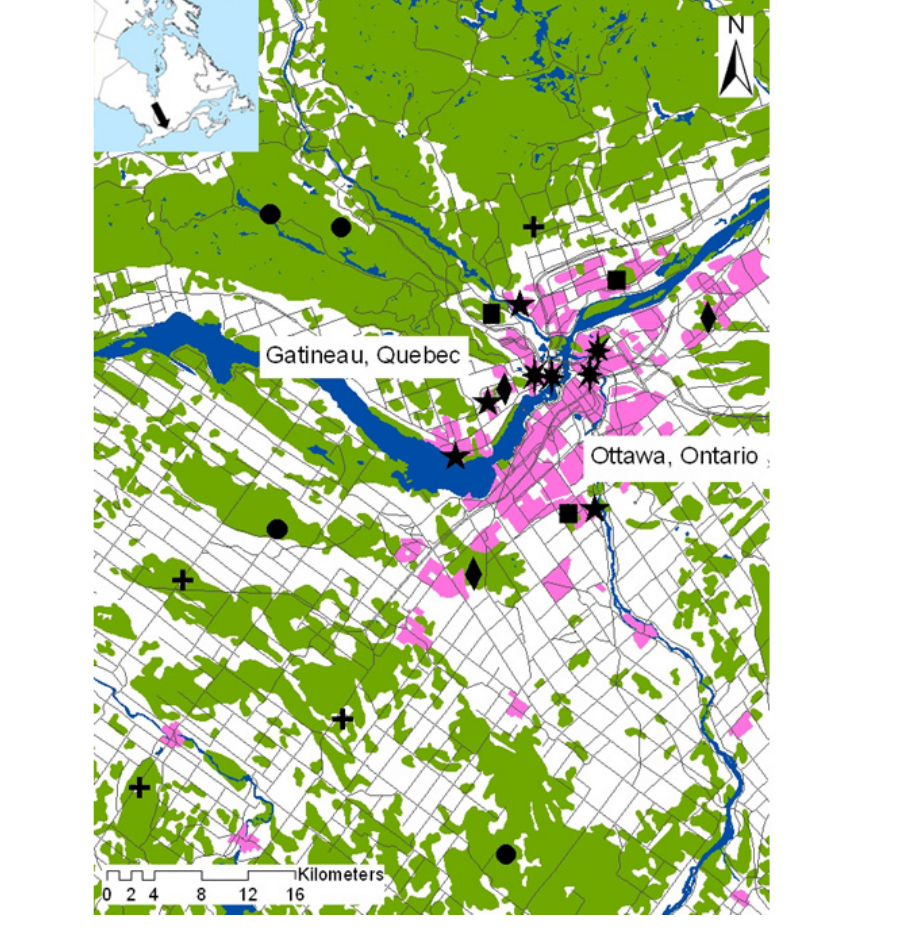
Fig. 1 . The study area in and around the cities of Ottawa, Ontario and Gatineau, Quebec, Canada. Inset depicts the location of the study area in eastern Canada. Beetle survey sites are 0.25-km² areas indicated by symbols representing six housing categories: Forested (circles, 0 dwellings/km²), Exurban (crosses, < 56 dwellings/km²), Suburban (stars, 140-712 dwellings/km²), Urban (asterisks, > 1,244 dwellings/km²); and two categories of forested sites adjacent to developments of Suburban or Urban densities: Suburban Neighbor (squares) and Urban Neighbor (diamonds). Dark gray lines indicate roads. Forest cover is in green, large waterbodies are in blue, and urban land cover is in